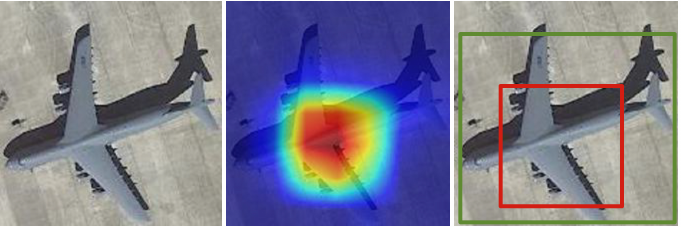
Figure 8. In the middle , an example of CAM for the “airplane” class obtained from the image on the left . On the right , the green BB is the ground truth, whereas the red BB is the one obtained by thresholding the CAM